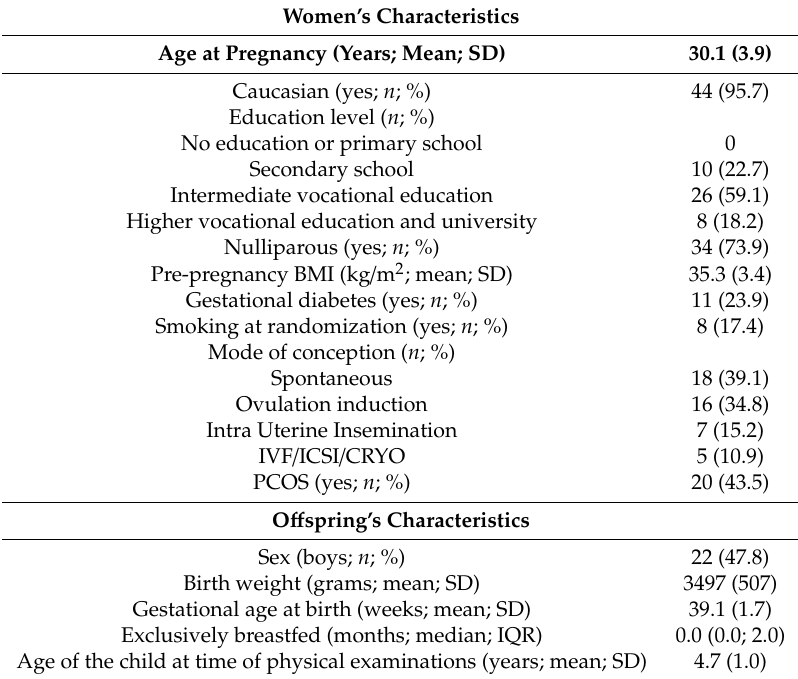
Table 1. Study characteristics of the participating women and their o ff spring ( n = 46) 1 .